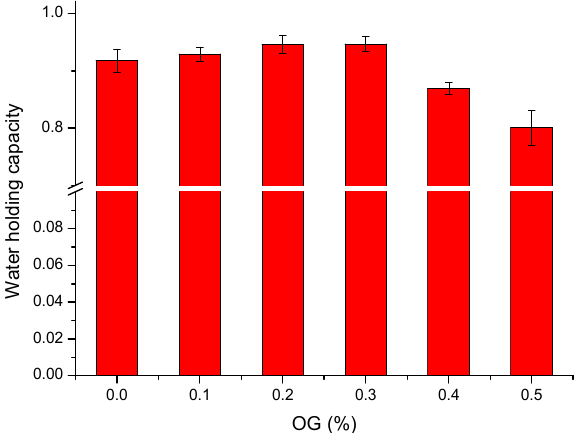
Figure 1. Comparison of WHC of set-type yogurt with different OG concentrations (0, 0.1%, 0.2%, 0.3%, 0.4%, and 0.5%).